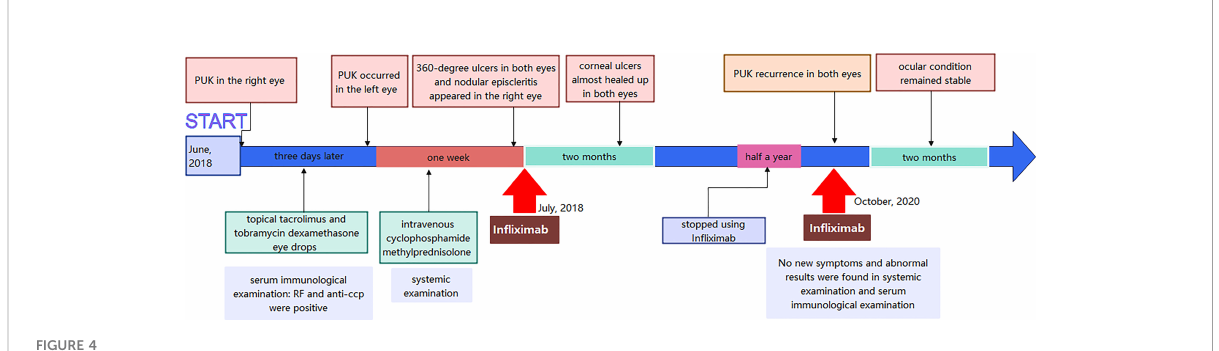
FIGURE 4 Timeline of the case report.